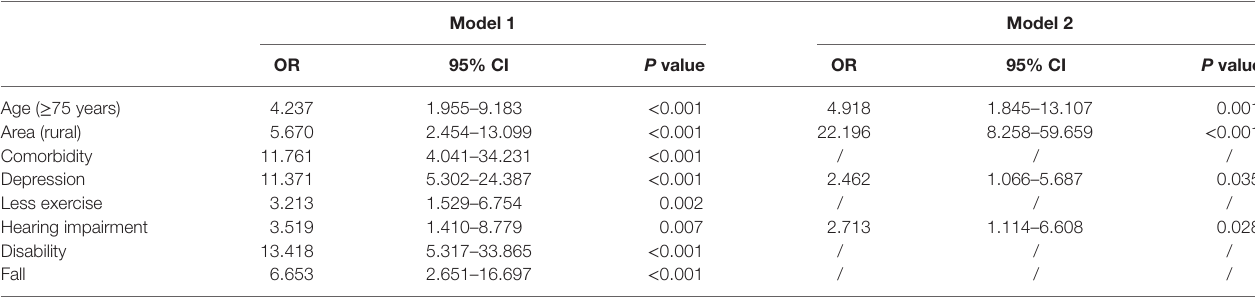
Model 1: Logistic regression for risk factors associated with CF in the robust and CF population. The variables not in the equation were gender, smoking, marital status, education, income, walking speed, vision impairment, low body mass index, and fracture. Adjusted for sociodemographic variables and age-related factors. Model 2: Logistic regression for risk factors associated with CF in the population with physical frailty. The variables not in the equation were gender, smoking, marital status, education, income, walking speed, vision impairment, comorbidity, exercise, disability, fall, low body mass index, and fracture. Adjusted for sociodemographic variables and age- related factors. OR, odds ratio; CI, confidence interval; CF, cognitive